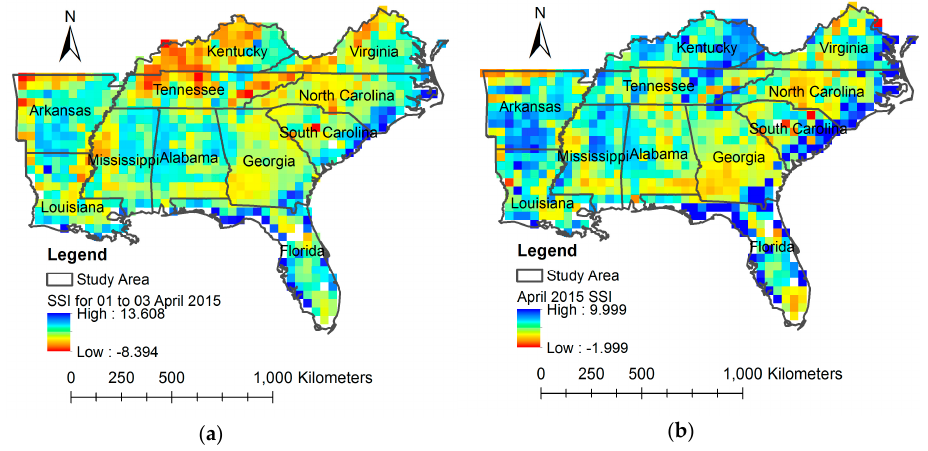
Figure 1. ( a ) Mosaic of the three consecutive standardized soil moisture index (SSI) maps from 1 to 3 April 2015. Areas in yellow to red represent areas that are experiencing very dry conditions, indicating drought. (b) SSI map for the whole month of April 2015.